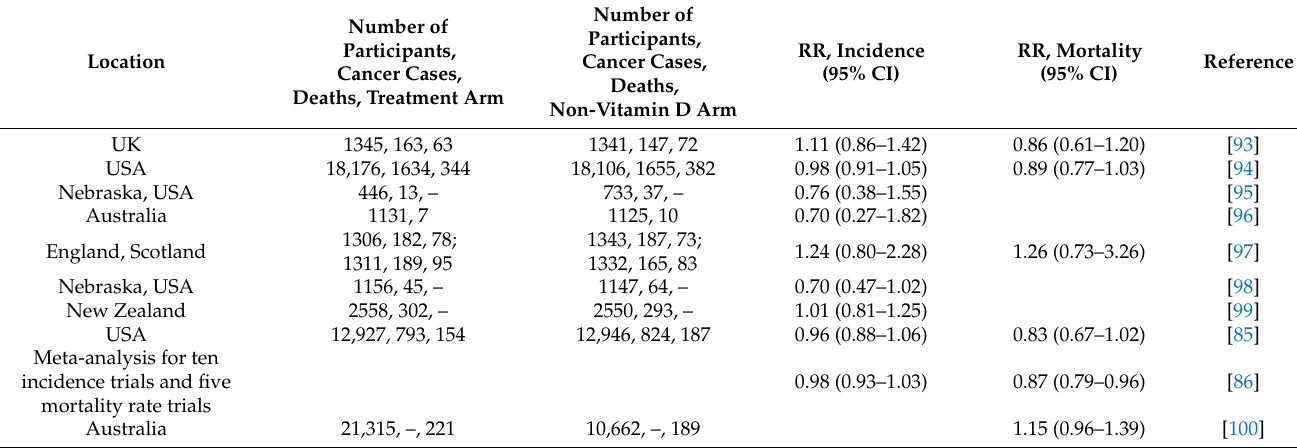
Table 9. Outcomes of ten RCTs that investigated the effect of vitamin D supplementation on risk of cancer incidence and/or mortality rate with respect to intention to